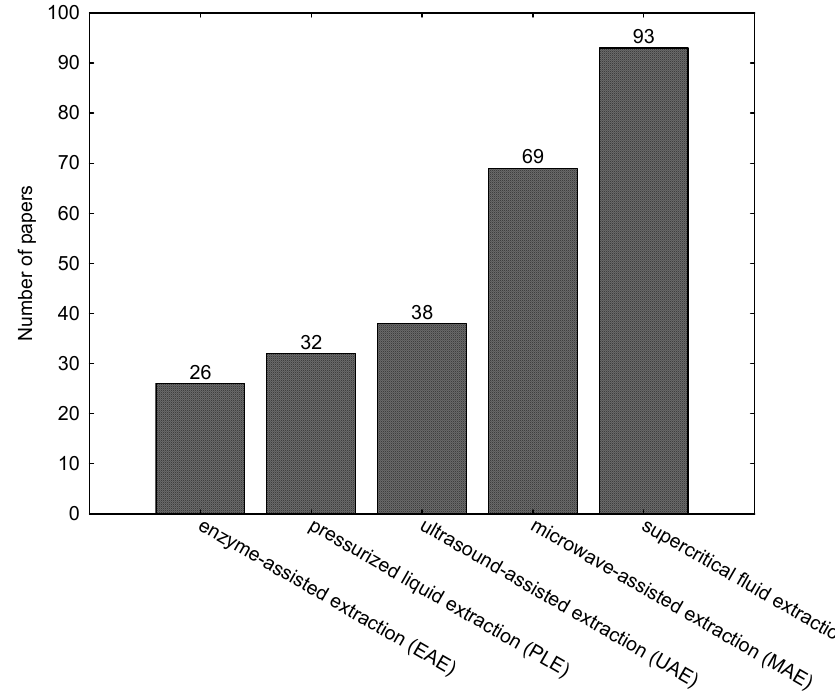
Figure 1. The number of scientific papers on extraction techniques of algae [2].